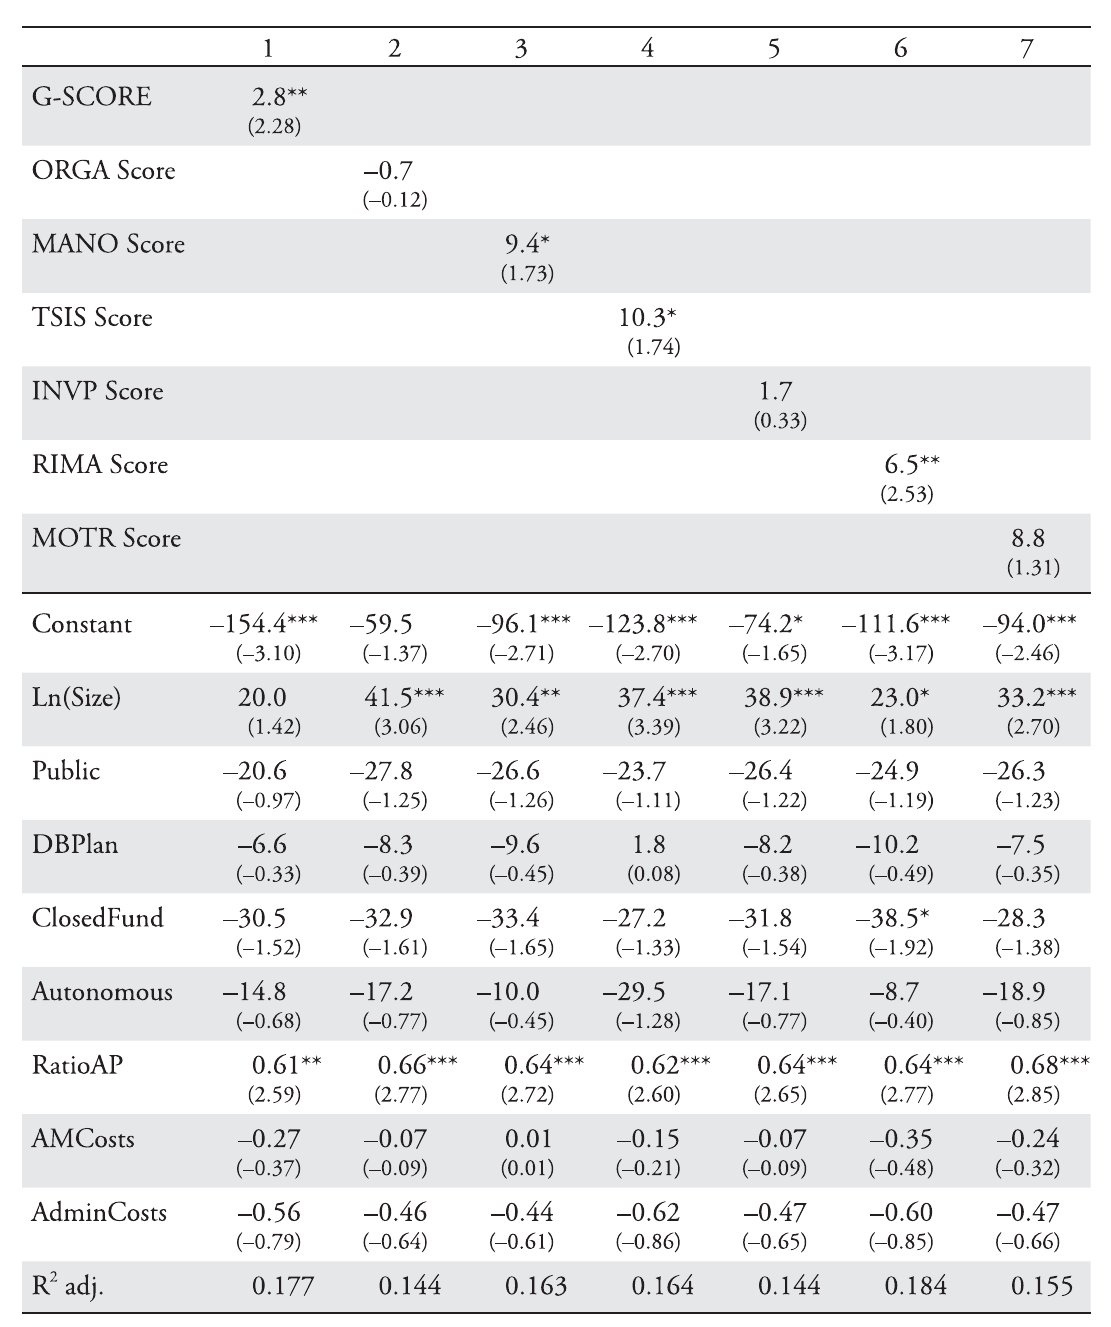
Table 14: Governance and Outperformance of the Passive Benchmark Dependent Variable =